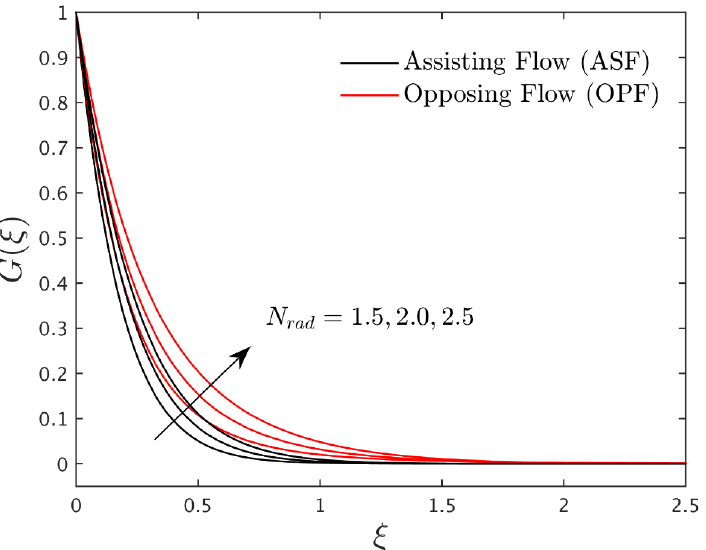
Figure 7. Temperature profile for the case of ASF and OPF due to variations in the values of N rad .